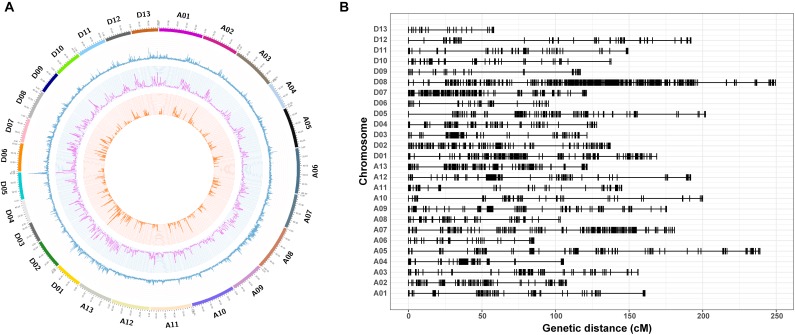
Genome-wide distribution of SNPs throughout the physical and genetic maps. (A) Genome-wide distribution of SNPs and genetic variants throughout the CRI50 and CRI60 genomes. The outermost box with a scale represents the 26 cotton chromosomes. The blue histogram represents the density of SNPs that are polymorphic between CRI50 and CRI60; the purple histogram indicates the density of insertions or deletions (Indels) between CRI50 and CRI60; and the orange histogram represents the density of aa × bb markers between CRI50 and CRI60. (B) Genetic map constructed by SNP markers.